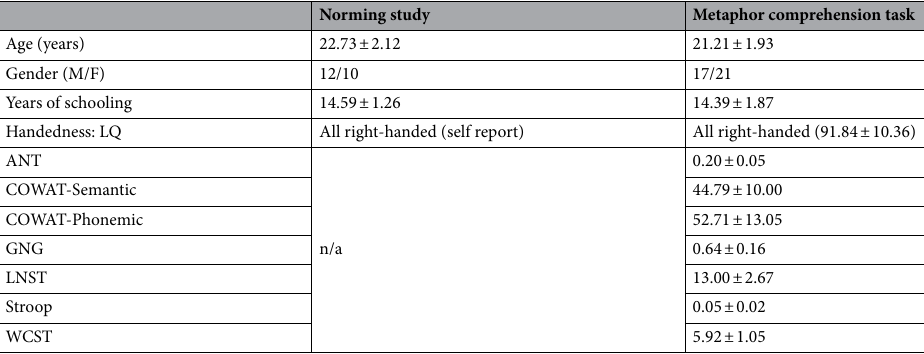
Table 4. Demographics of participants from the norming study and metaphor comprehension task and their scores of neuropsychological tests (mean ± SD). LQ laterality quotient 99 , ANT attention network test, COWAT